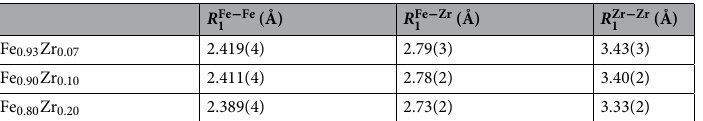
Table 2. Peak positions of the first Gaussian, R 1 , obtained fitting Eq. (1) to the partial Fe-Fe, Fe-Zr, and Zr-Zr radial distribution functions for the simulated amorphous structures of Fe 0.93 Zr 0.07 , Fe 0.90 Zr 0.10 , and Fe 0.80 Zr 0.20